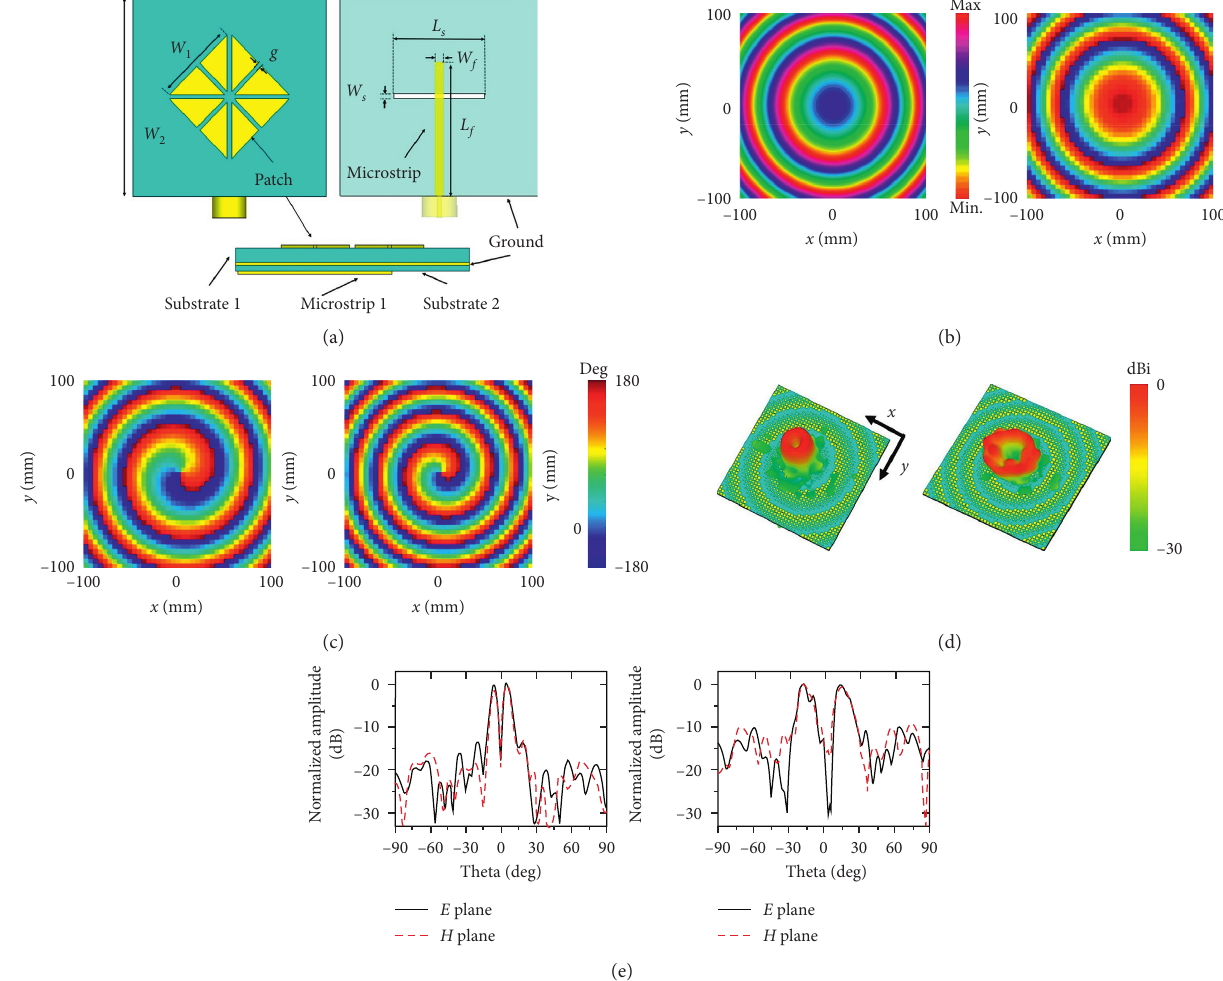
Figure 3: (a) Schematic of the feed antenna. The middle metallic pattern has a slot cut in it with a length of Ls � 12.2mm and width of Ws � 0.65 mm. (b) Continuous phase profile of the primary feed antenna illuminating the metasurface (left panel), and phase distribution used to compensate the out-of-phase incidence (right panel). (c) Transmission phase function of the metasurface. (d) 3D simulated far-field radiation pattern. (e) 2D simulated results in the E and H planes for OAM l � 1 at δ r � 0 ° (left panels) and δ r � 15 ° (right